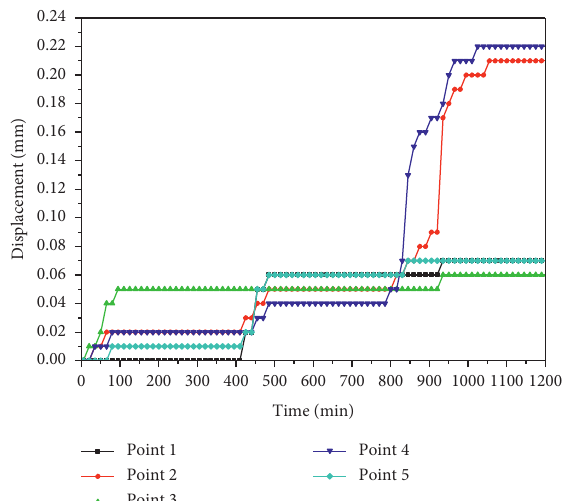
Figure 4: Displacement duration curve of L3 section in excavation scheme I.